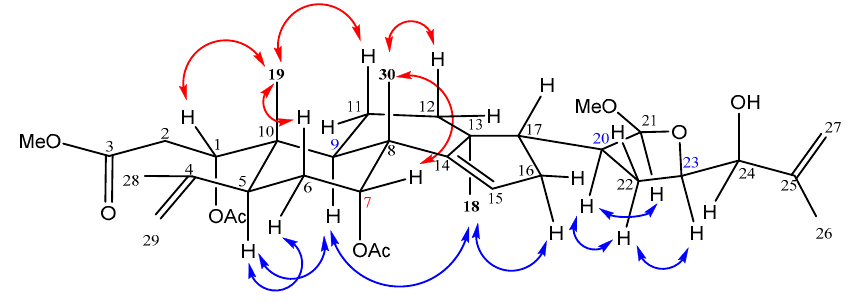
Figure 3. Key NOESY correlations of 1 .